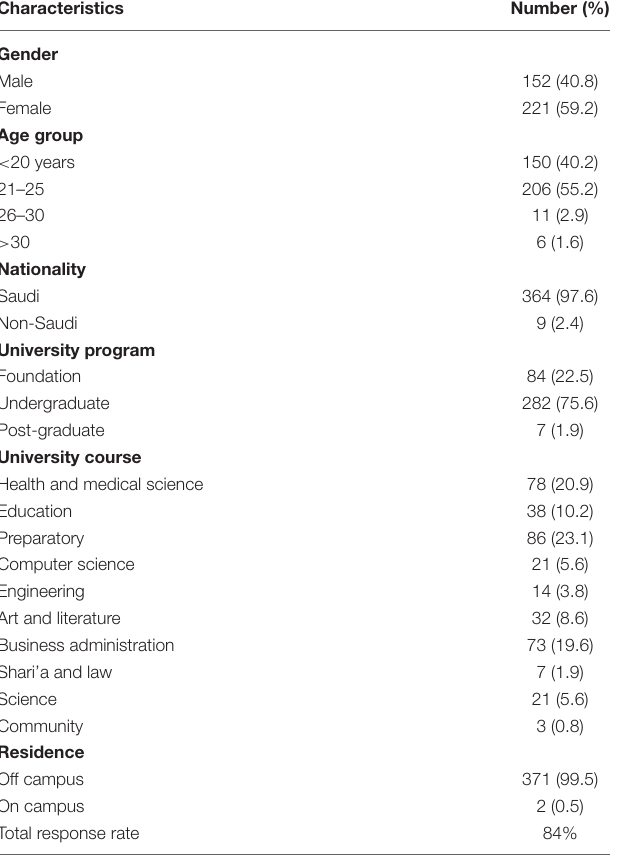
TABLE 1 | Participant demographics ( N = 373). TABLE 2 | Self-medication prevalence among university students ( N = 373). Conditions for